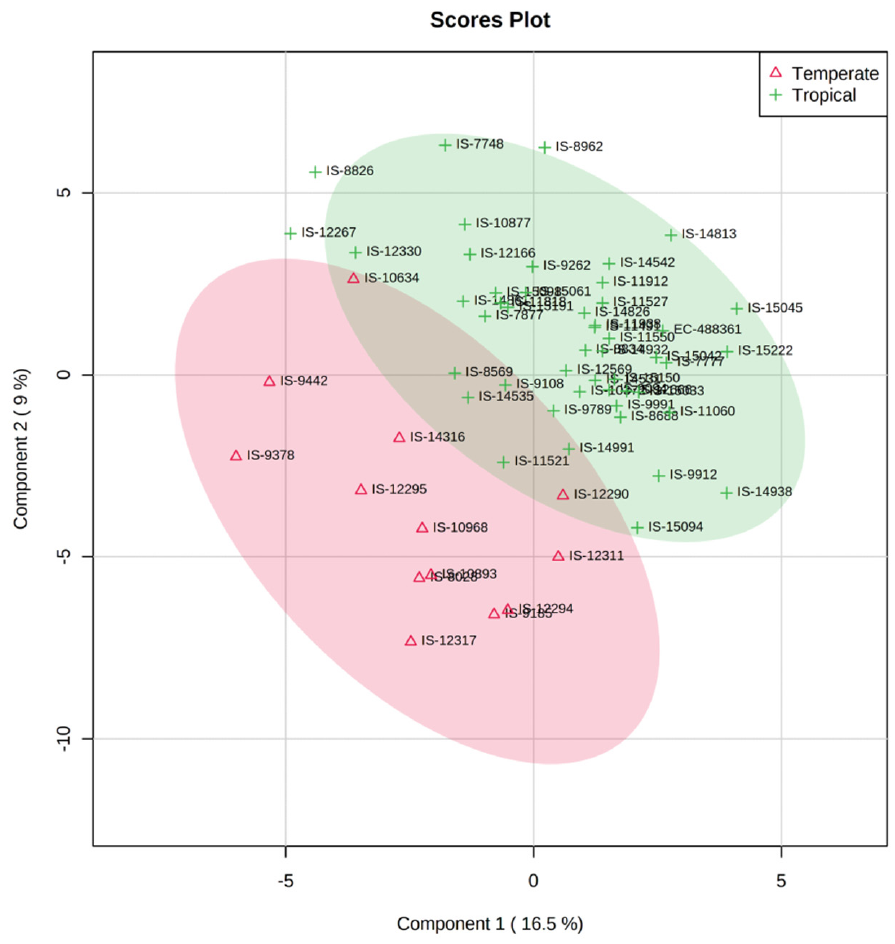
Figure 4. Partial least squares discriminant analyses (PLS-DA) analysis of sorghum grain metabolome. The first two principal components (PCs) explain 25.5% of variance separating tropical and temperate sorghum.